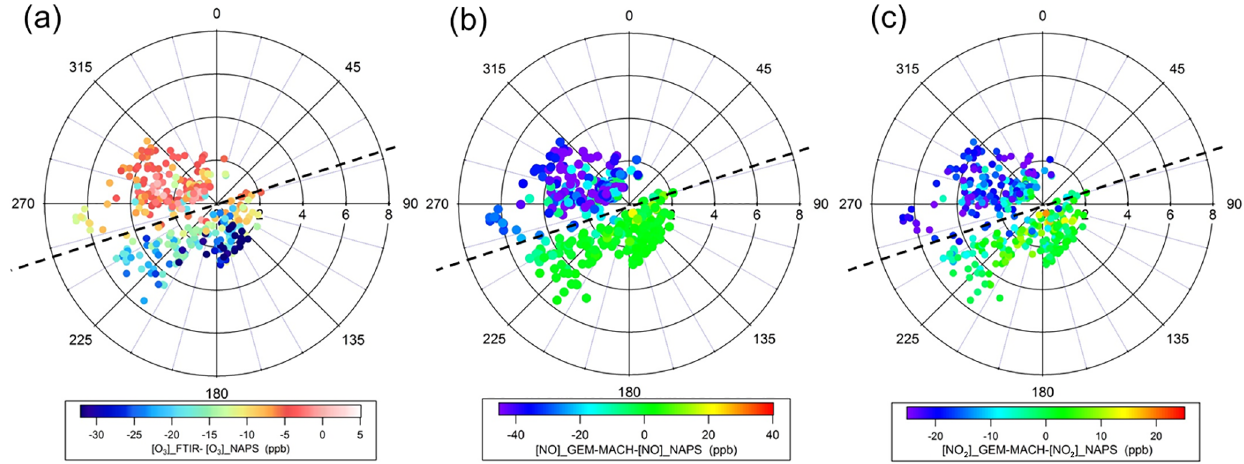
Figure 7. Polar plots of O 3 mixing-ratio difference between measurements from the FTIR spectrometer and the NAPS (a) ; mixing-ratio difference between results from GEM-MACH predictions and hourly averaged measurements from NAPS for NO (b) and NO 2 (c) . Azimuth angle represents wind direction (meteorological convention), and radius indicates wind speed (ms − 1 ) . The centre of each plot corresponds to the location of the NAPS trailer. The black dashed line shows the orientation of the highway: above this line, the wind came across the highway to the trailer.